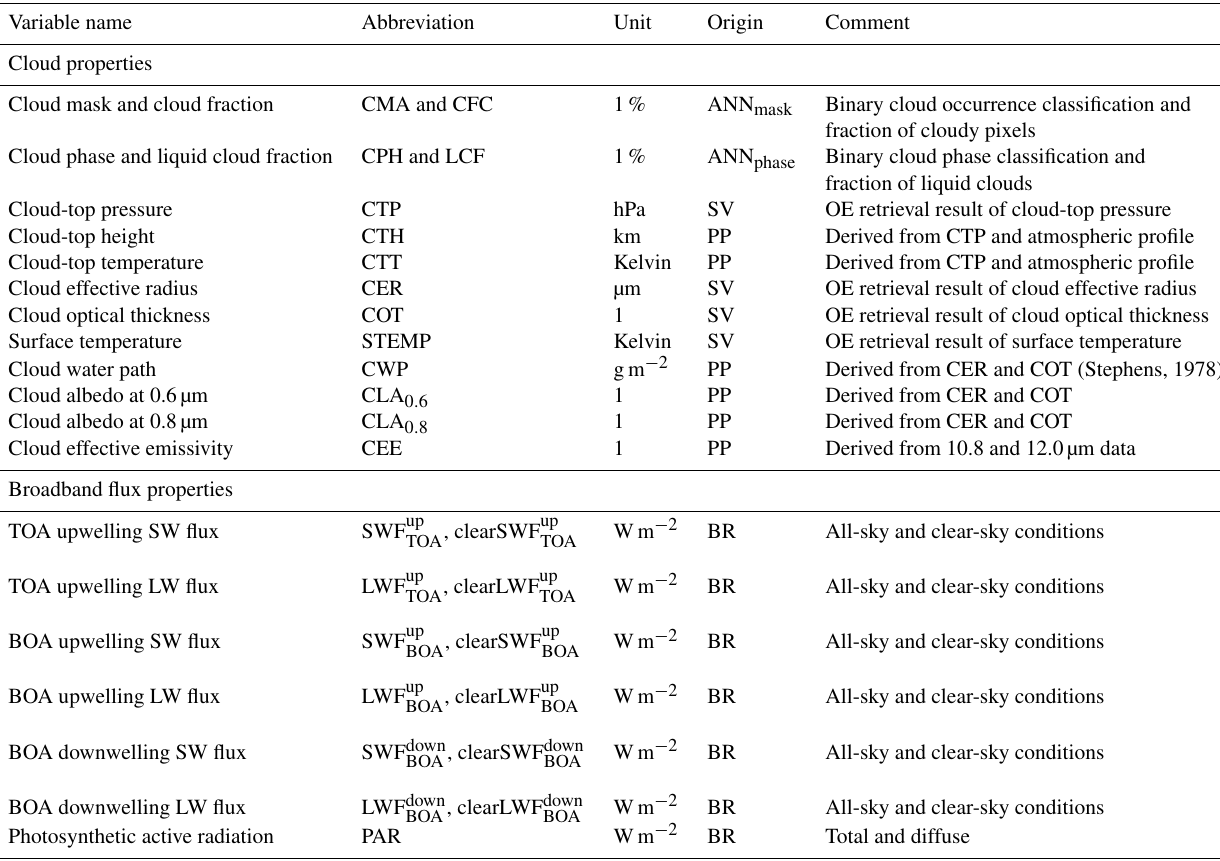
Table 1. Cloud_cci AVHRR-PMv3 cloud and radiation properties. ANN mask is artificial neural network for cloud detection, ANN phase is artificial neural network for cloud phase, SV is state vector, PP is post-processed, PV is Pavolonis algorithm (Pavolonis and Heidinger, 2004; Pavolonis et al., 2005), OE is optimal estimation, BR is BUGSrad (radiative flux algorithm), TOA is top of atmosphere, BOA is bottom of atmosphere (surface), LW is longwave and SW is shortwave. Upper part of the table (cloud properties) has been adapted from Sus et al.